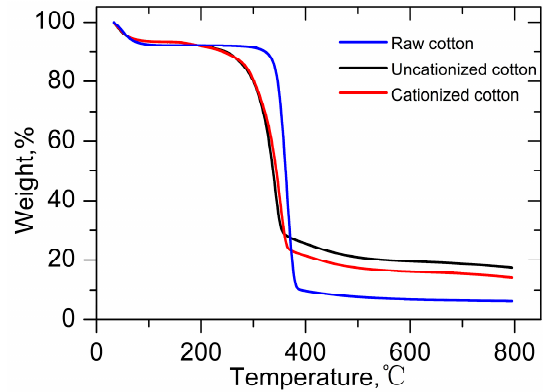
Figure 6. Thermogravimetric analysis of raw, uncationized, and cationized cotton.